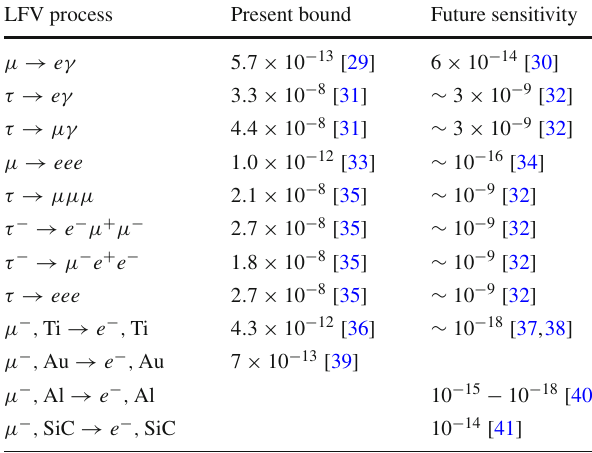
Table 1 Current experimental bounds and future sensitivities for the most important LFV observables LFV process Present